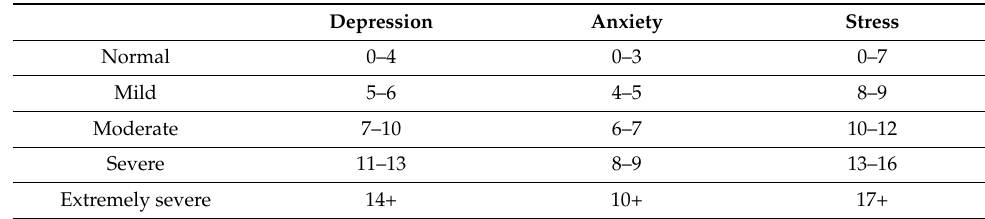
Table 1. Cut-off scores for